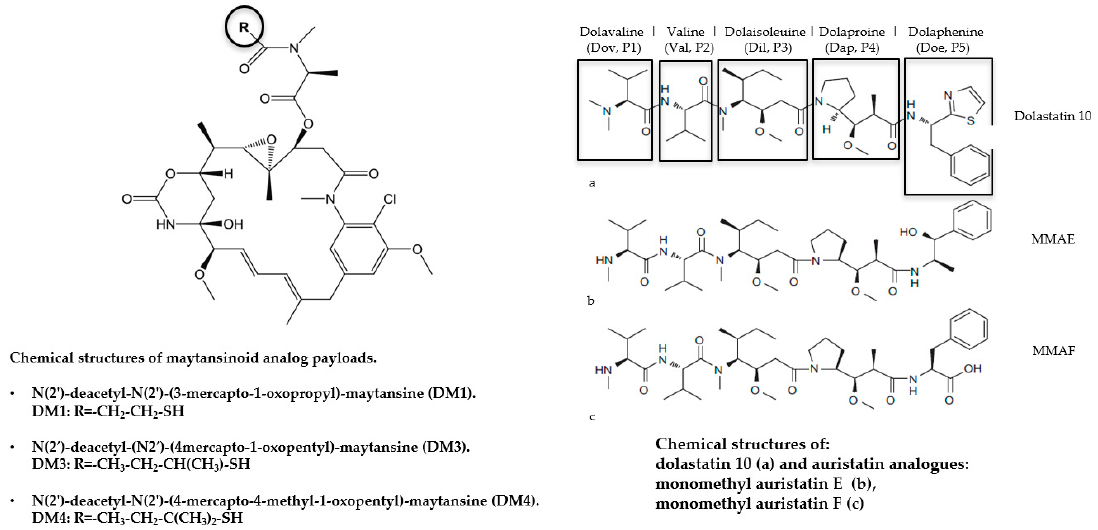
Figure 6. Classical microtubule-targeting agents: maytansinoids ( left ) and auristatin families ( right ). Auristatin is a dolastatin synthetic analog. The original drug was isolated from Dolabella auricularia (sea hare) as dolastatin peptides, which successfully improved its water solubility to give auristatin [54]. Auristatins block tubulin assembly and induce cell cycle arrest in G2/M phase, causing cells to undergo apoptosis.